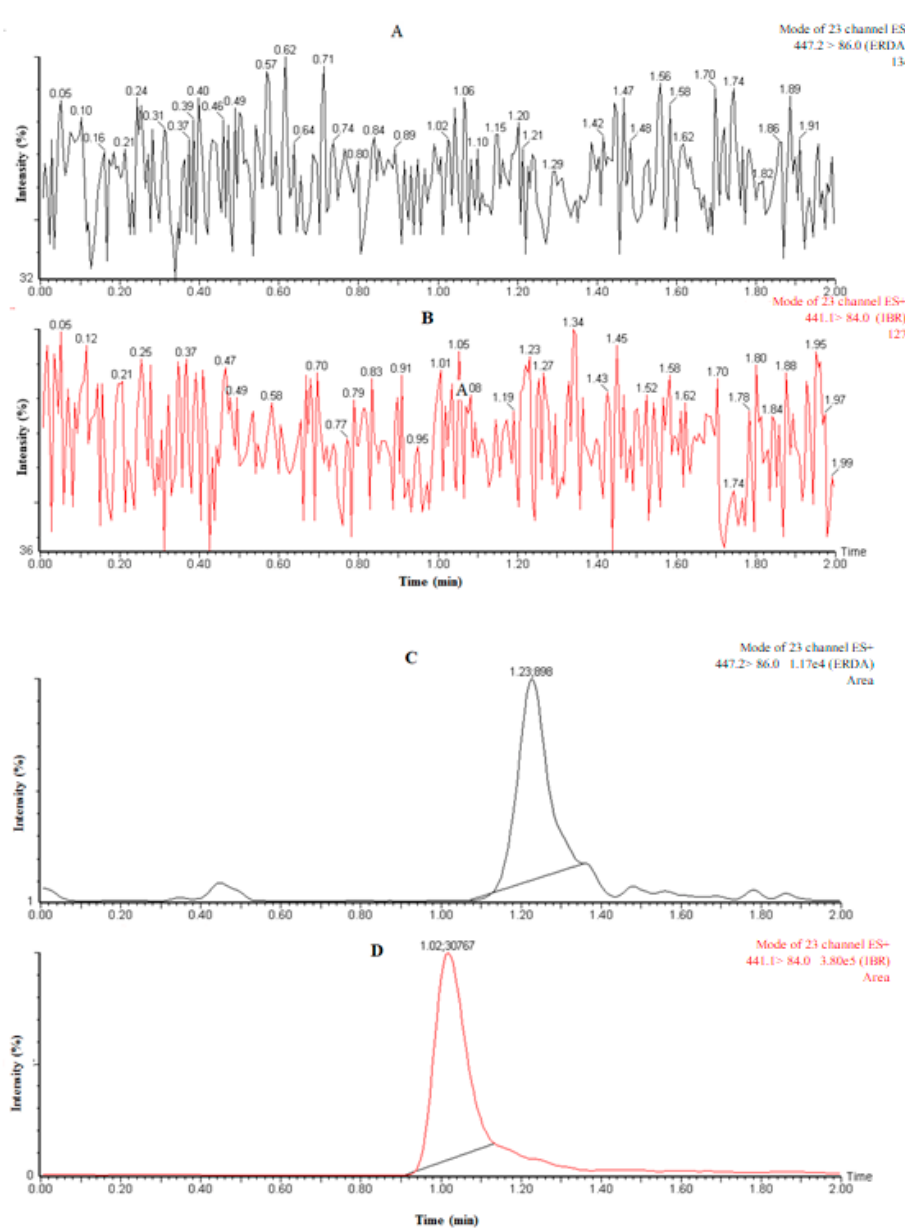
Figure 3. MRM Chromatograms of ERDA and internal standard in blank plasma ( A,B respectively), and plasma spiked at LLOQ (low limit of quantitation) ( C , D ,